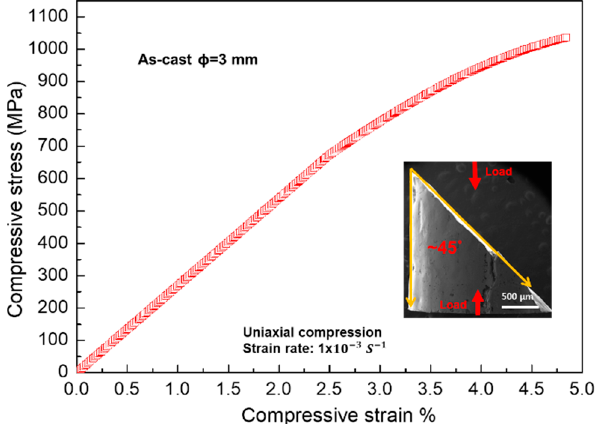
Figure 9. Compressive stress and strain of quaternary Al-Cu-Si-Mg eutectic alloy.